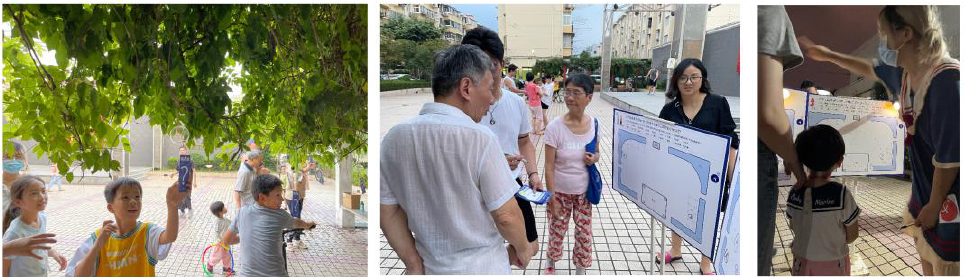
Figure 2. Community participatory research on-site activity. This activity was used to ask the crowd what activities they were actively participating in in the square space.